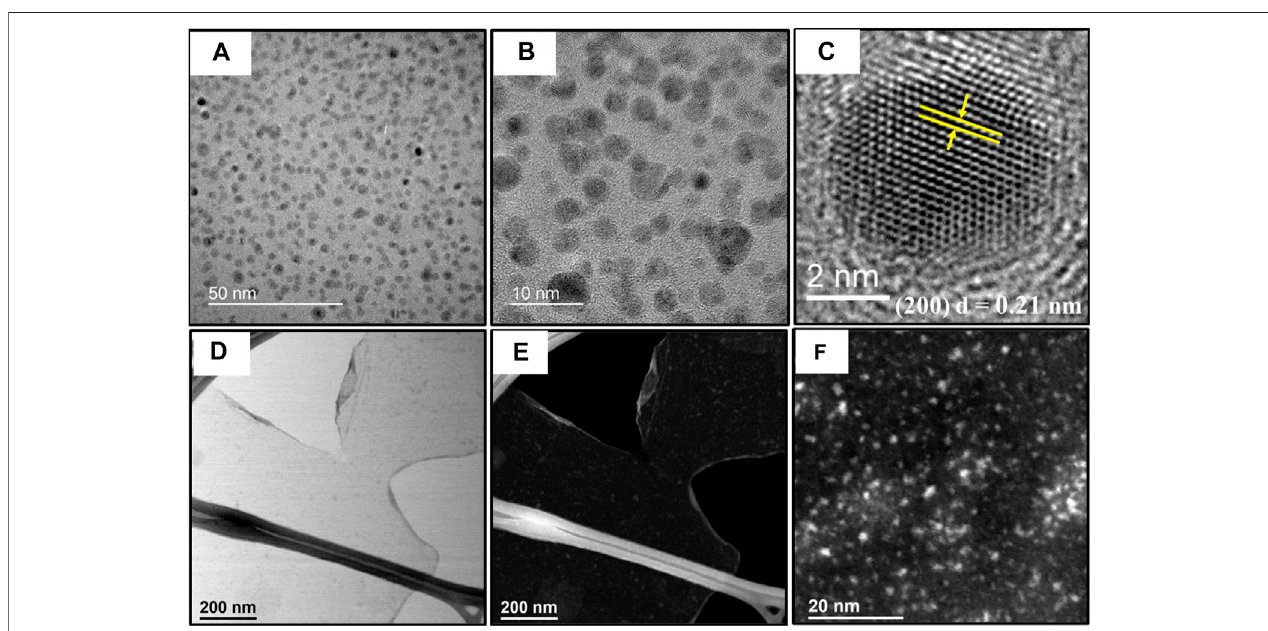
FIGURE3|(A,B) TEMimagesofNi 0.9 V 0.05 Ce 0.05 -LDHNPs/GOwithmagni fi cationgrowingfromlefttoright. (C) HRTEMoftrimetallicoxideNPsformed insitu after dehydroxylation/dehydration reaction induced by electron beam. (D) Bright fi eld-STEM image showing Ni 0.9 V 0.05 Ce 0.05 -LDH NPs dispersed on GO surface and (E) same image in (D) in HAADF mode. (F) Higher magni fi cation HAADF-STEM image of Ni 0.9 V 0.05 Ce 0.05 -LDH